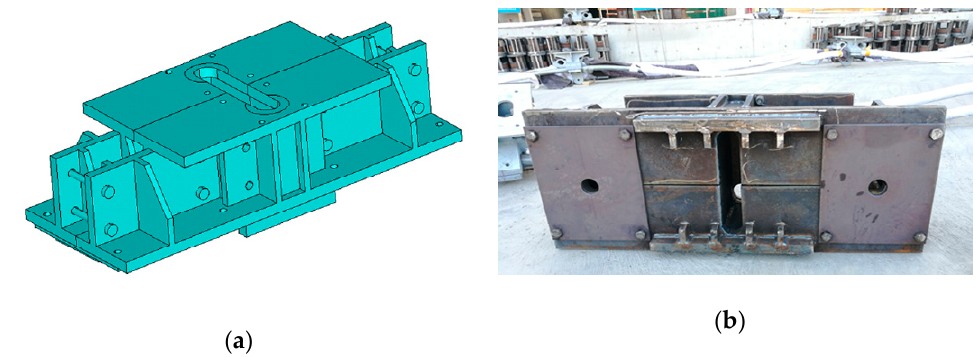
Figure 7. Virtual–real interaction of materials. ( a ) Virtual model; ( b ) Real